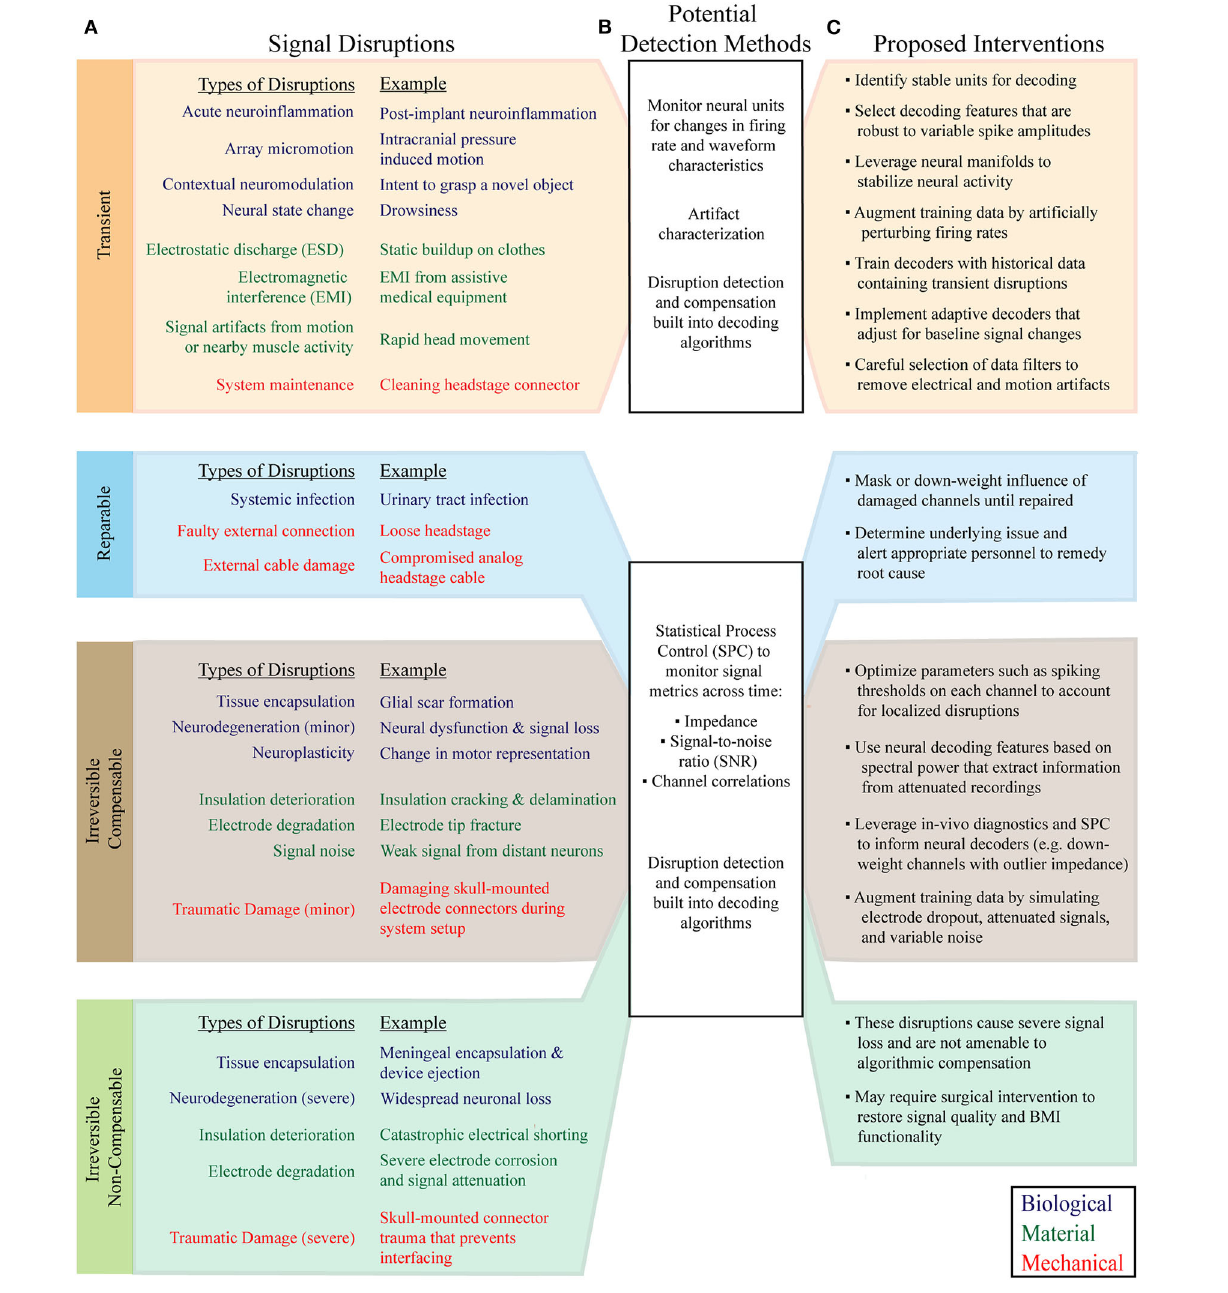
biological responses decrease recording consistency, which can negatively impact BMI decoder performance. Resolution of